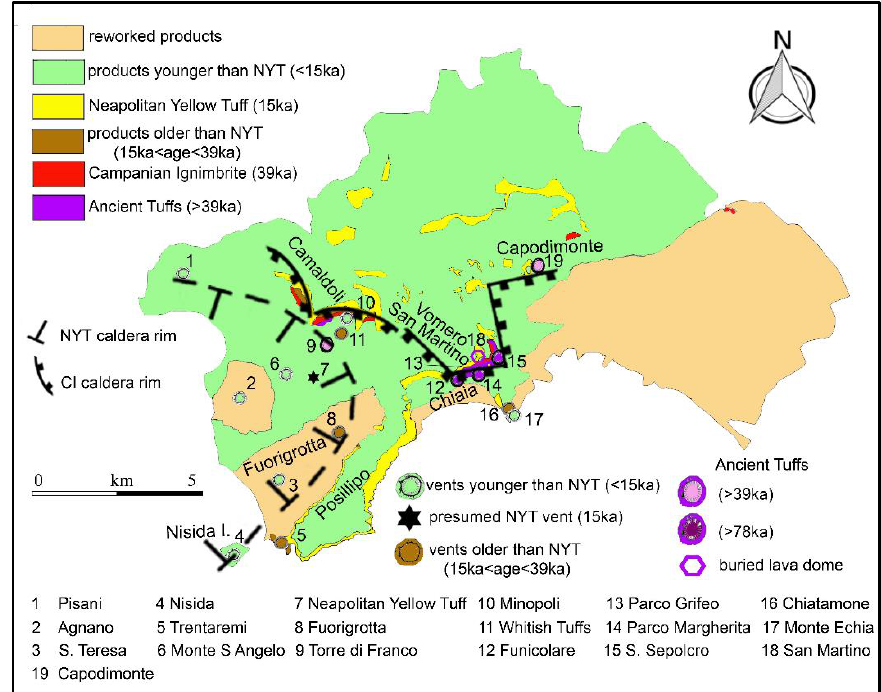
Figure 2. Geological sketch map of the Naples municipality area. Caldera rims associated with two large Plinian and Phreatoplinian eruptions are also illustrated (CI and NYT) (modified after